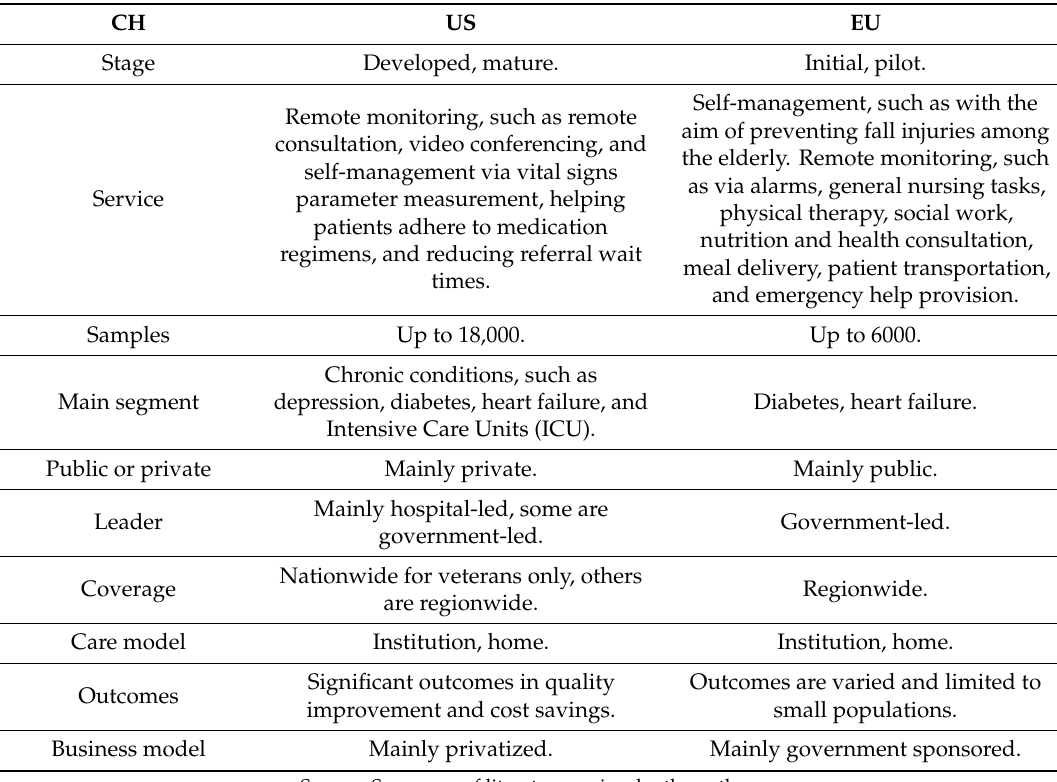
Table 2. Comparison of connected health (CH) in the US and